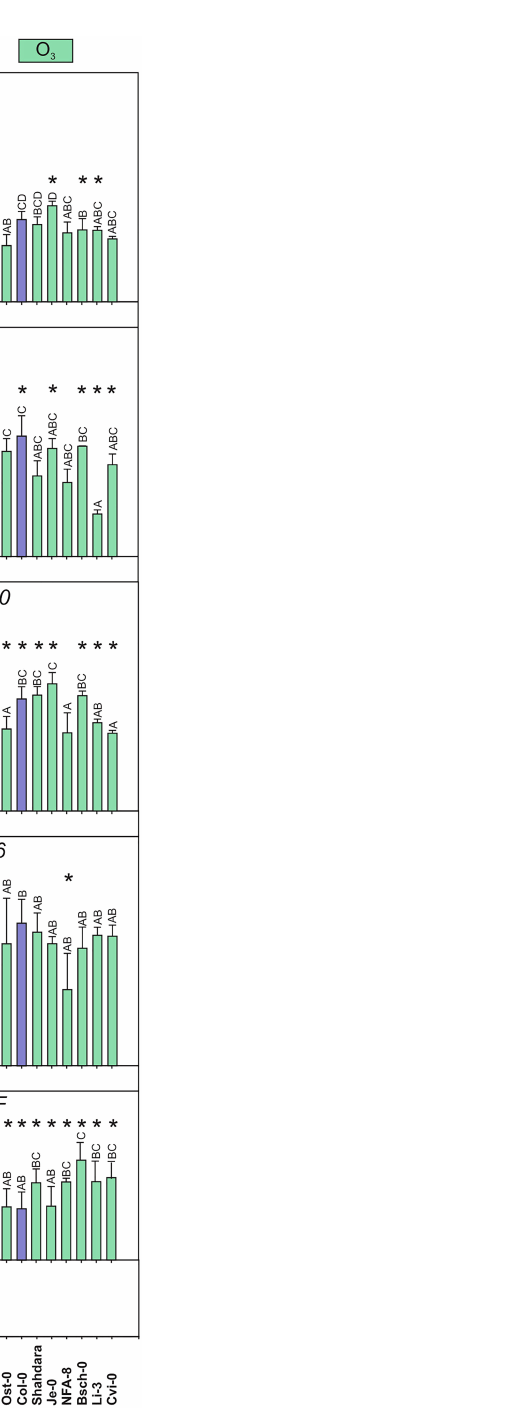
FIGURE 2 Transcript levels after NO 2 and O 3 treatments in different accessions. Transcript levels of fi ve marker genes was measured with qPCR in natural accessions of A. thaliana 2 h after treatments with NO 2 (left column) and O 3 (right column). Log 2 – transformed fold change of marker genes in natural accessions are shown from three biological replicates. Statistical analysis was performed with a linear mixed model ( P < 0.05). Letters from a to e represent comparison of NO 2 treatment effect, and letters from A to D O 3 treatment effect, on different genotypes. Asterisks (*) represent statistical differences between NO 2 and O 3 treatments on each genotype. Error bars display standard deviation. The accessions were selected to include genotypes with differential NO 2 and O 3 damage phenotypes (see also Figure